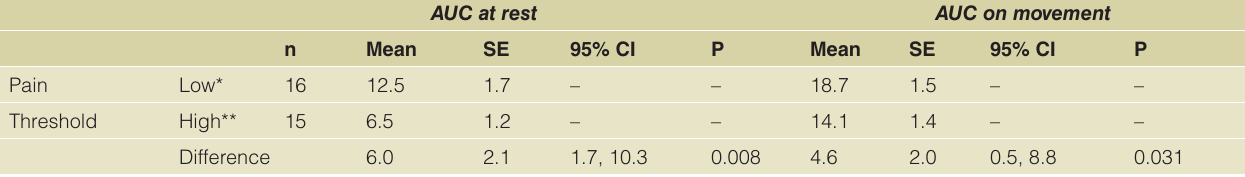
Table 3. Post-operative pain experienced (Area under the curve, AUC) by low and high pain threshold